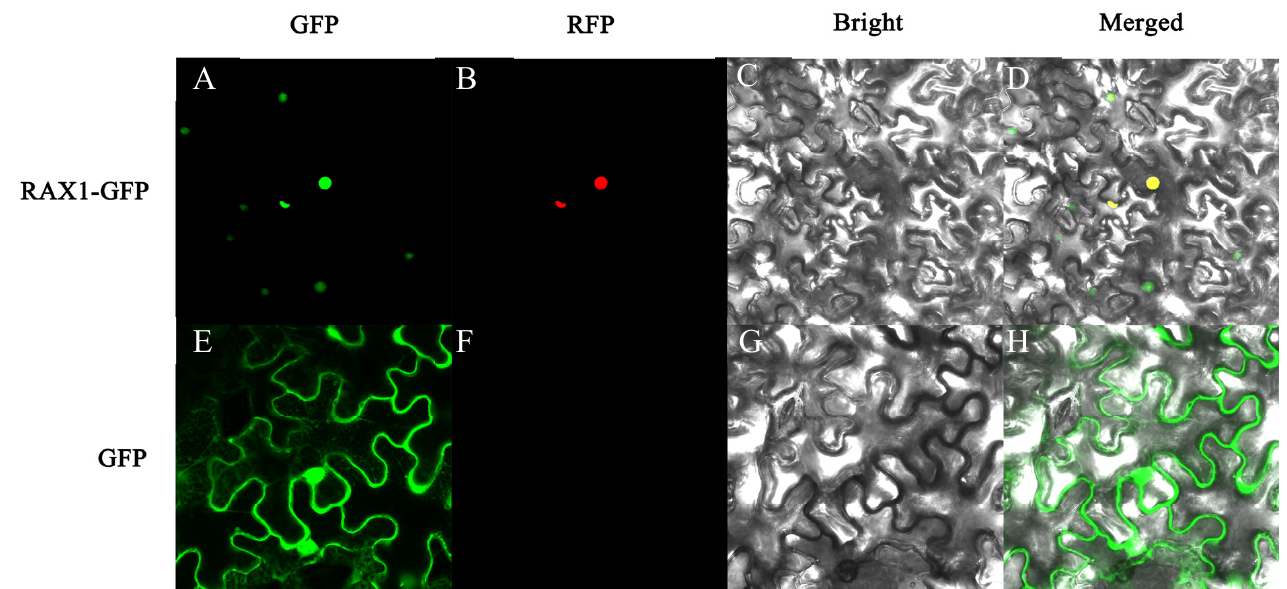
Figure 4. Expression analysis of PhMYB37 . ( A ) The expression analysis of PhMYB37 in different tissues. ( B ) The expression analysis of PhMYB37 under different treatments. Three pools of 20 plant- lets served as the source of all samples. Decap represents decapitation.